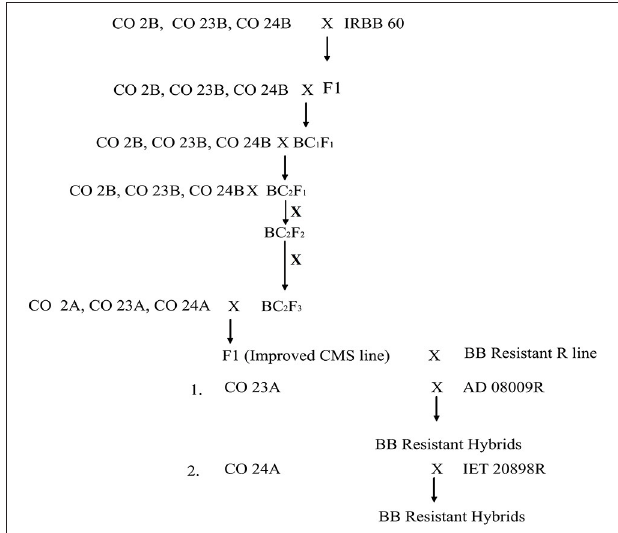
FIGURE 2 | Schematic representation of the introgression of xa5, xa13, and Xa21 into the maintainer and CMS line.